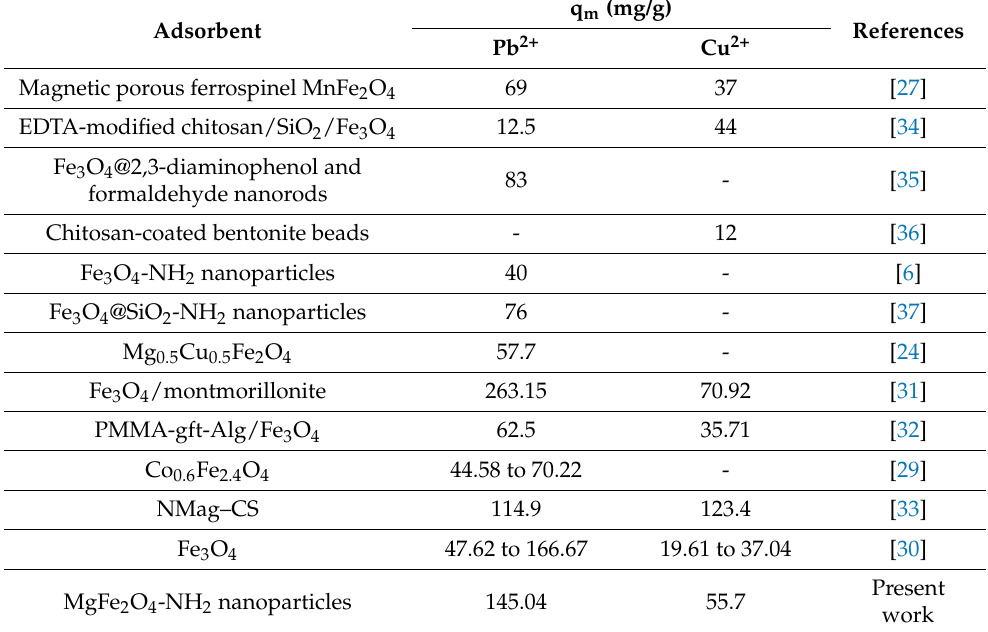
Table 7. A comparison of maximum adsorption capacities of different